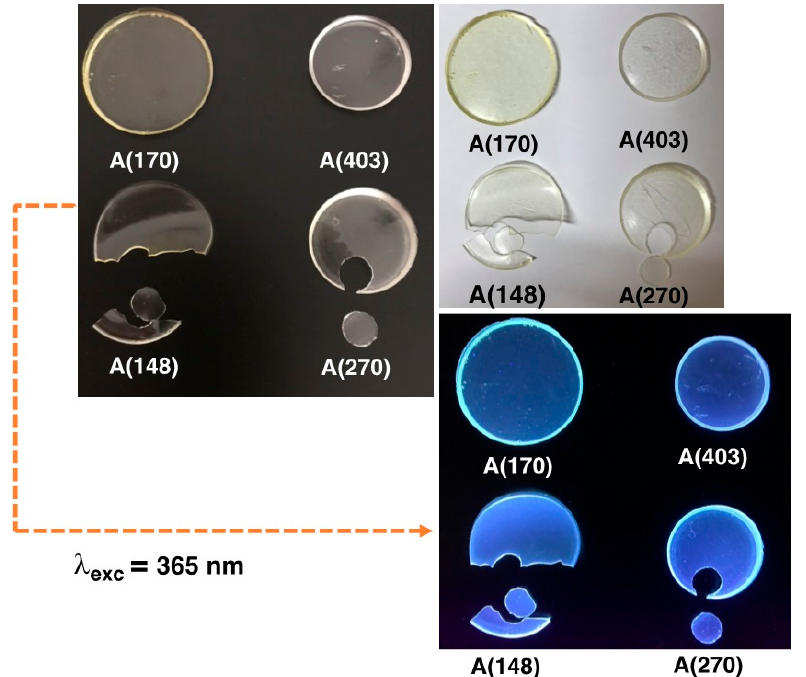
Figure 5. Amino-alcohol silicate samples and their photoluminescence response after an excitation with a light with a wavelength of 365 nm.